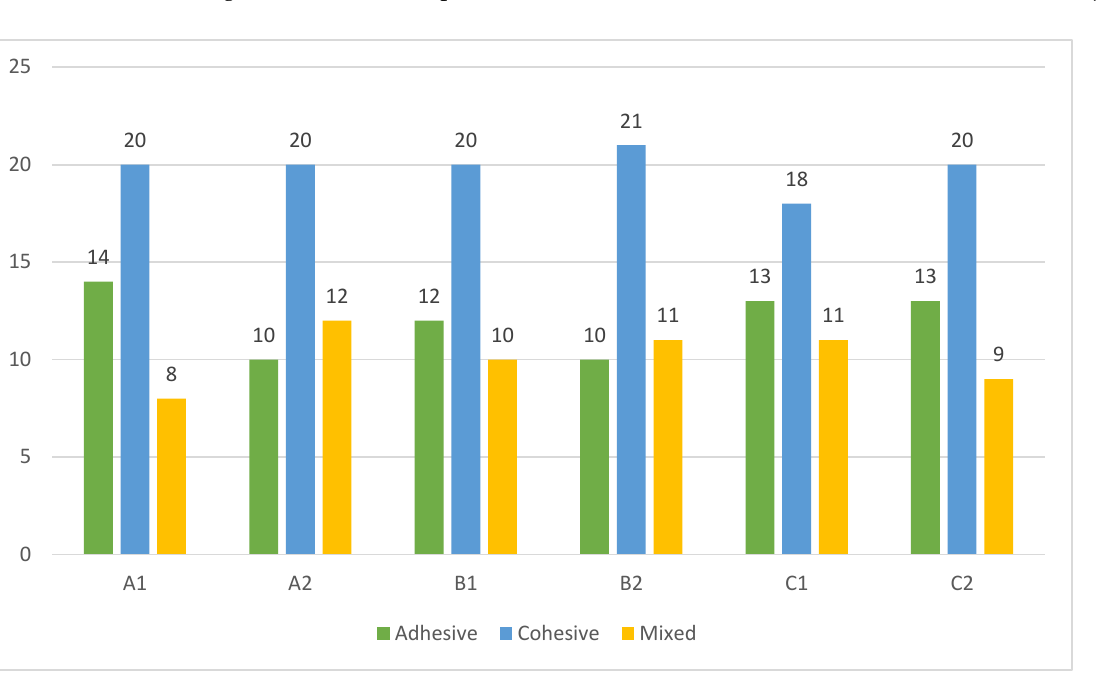
Figure 3. Frequency distribution of the 252 specimens according to the sub-groups and modes of failure.